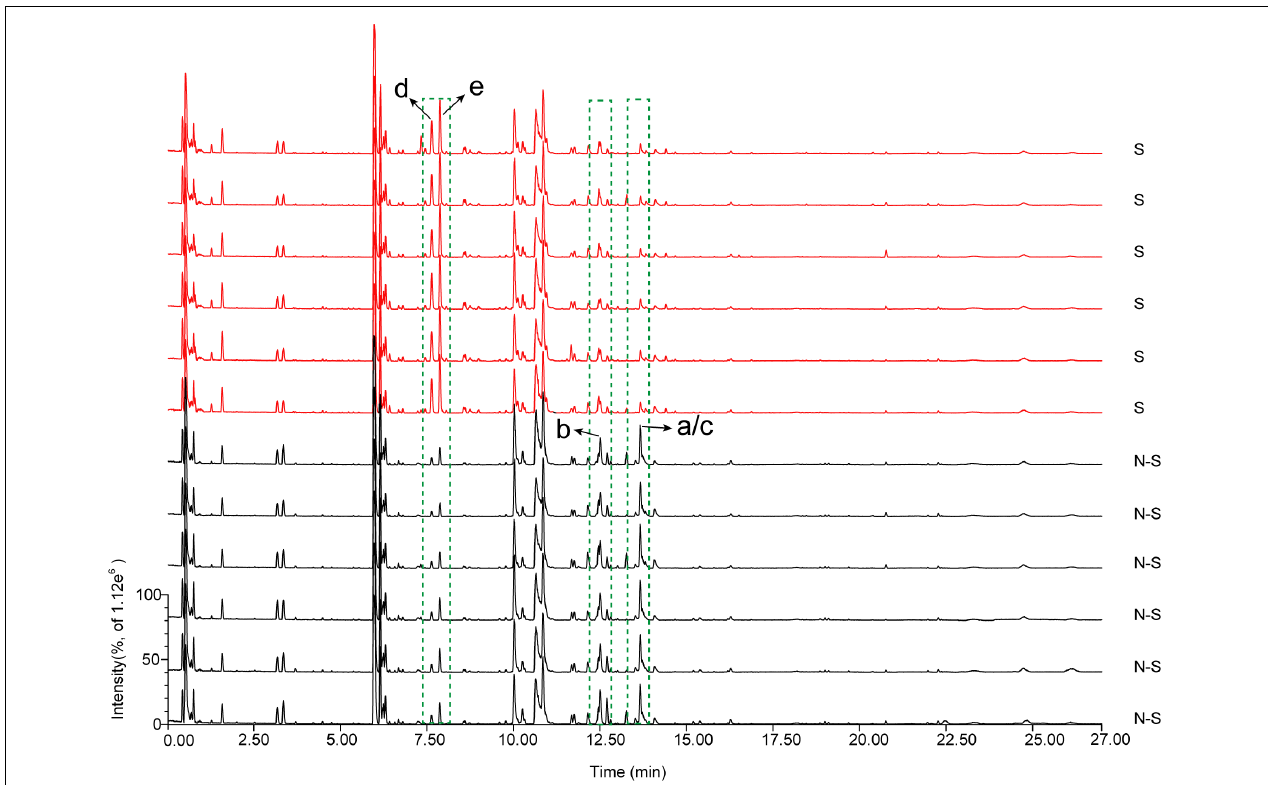
FIGURE 1 | Overlay of total ion chromatograms of AB extracts for non-fumigated (N-S) and sulfur-fumigated (S) in positive mode (compounds a–e are the significantly different compounds).